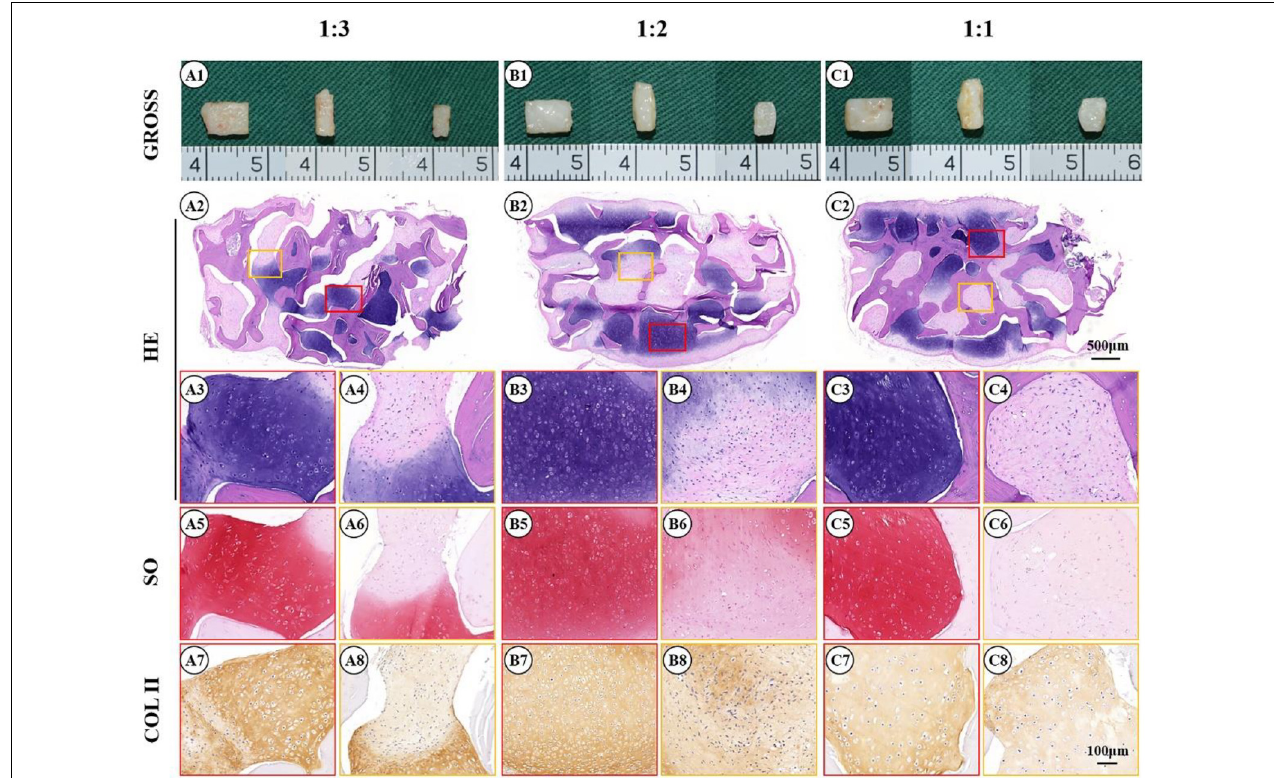
FIGURE 7 | Gross view and histological examination of the cartilage regenerated by human engineered cartilage gel (ECG) after 12 weeks in vivo implantation in nude mouse. Gross view, HE, Safranin-O, and collagen II immunohistochemical staining of 3 d ECG–decalcified bone matrix (DBM) constructs in 1:1 (A1–A8) , 1:2 (B1–B8) , and 1:3 (C1–C8) dilution ratios. The red box represents the mature cartilage-like tissue areas, and the orange box represents immature cartilage-like